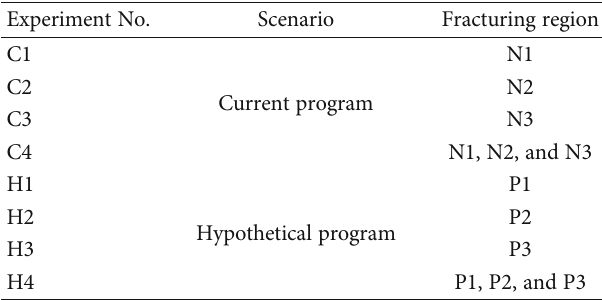
Figure 7: Schematic of di ff erent locations of the fracturing region. Table 2: Numerical experiments according to di ff erent fracturing